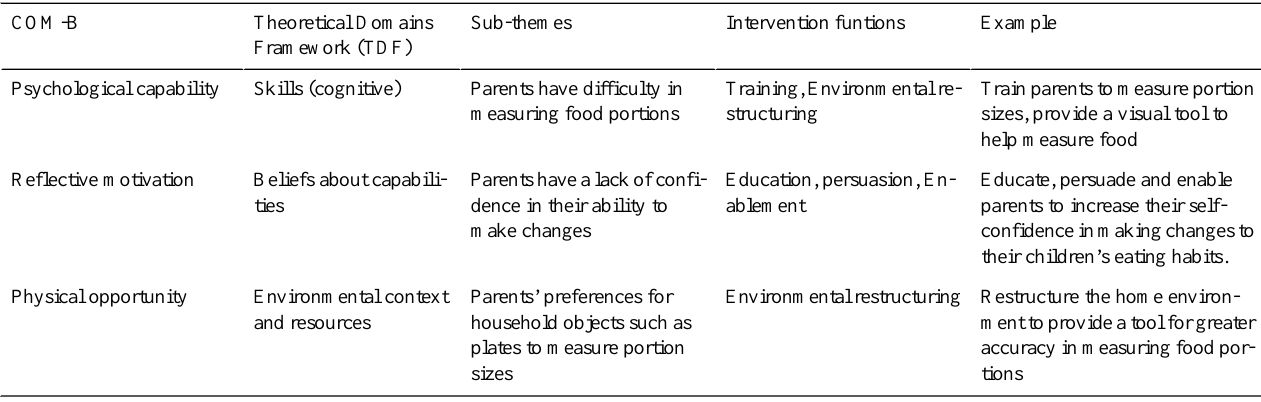
Table 3. Excerpt of mapping intervention functions to COM-B and Theoretical Domains Framework (TDF)